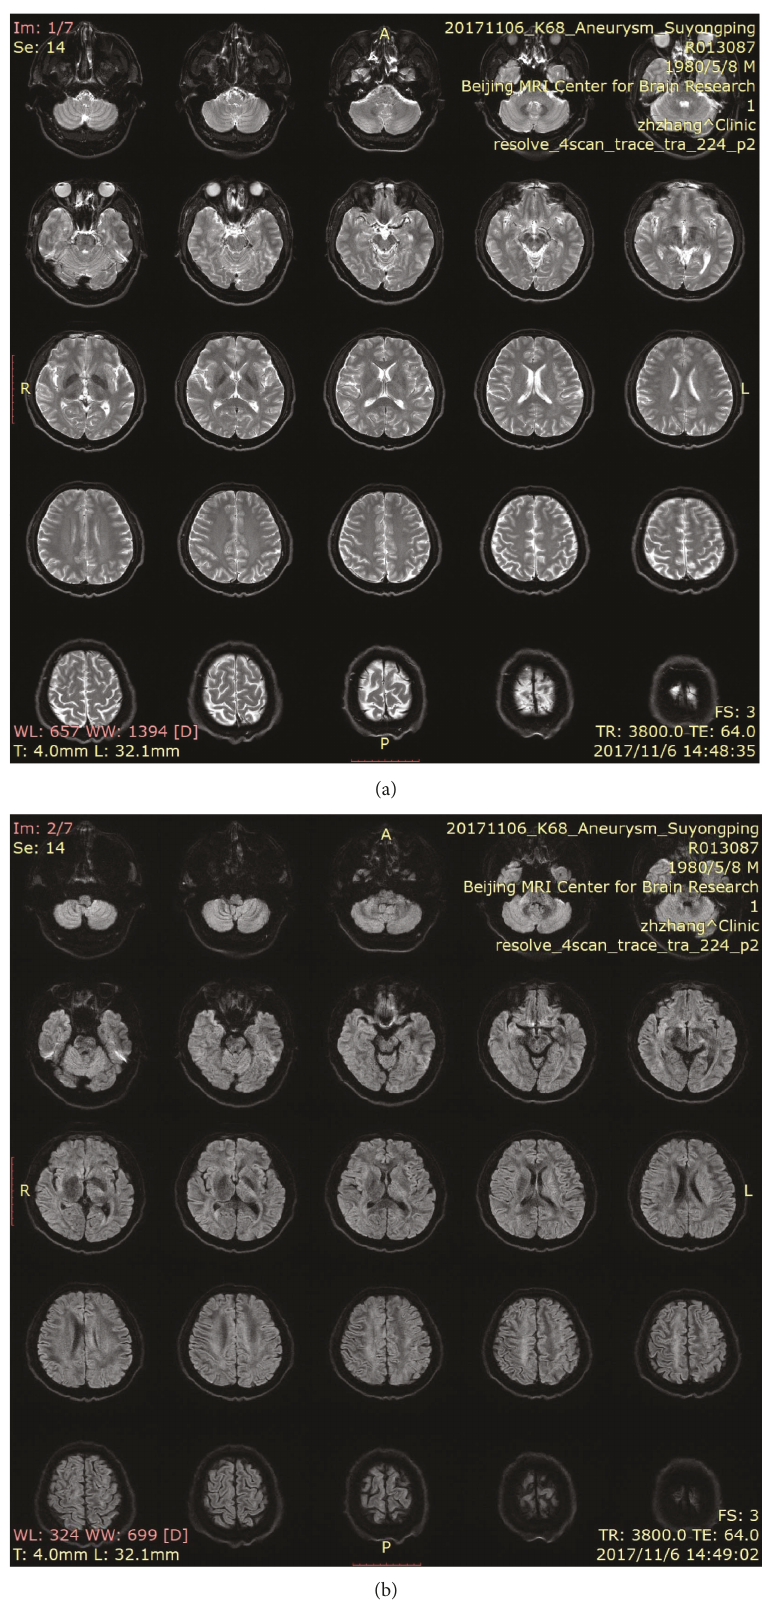
Figure 9: Postoperative head nuclear magnetic resonance